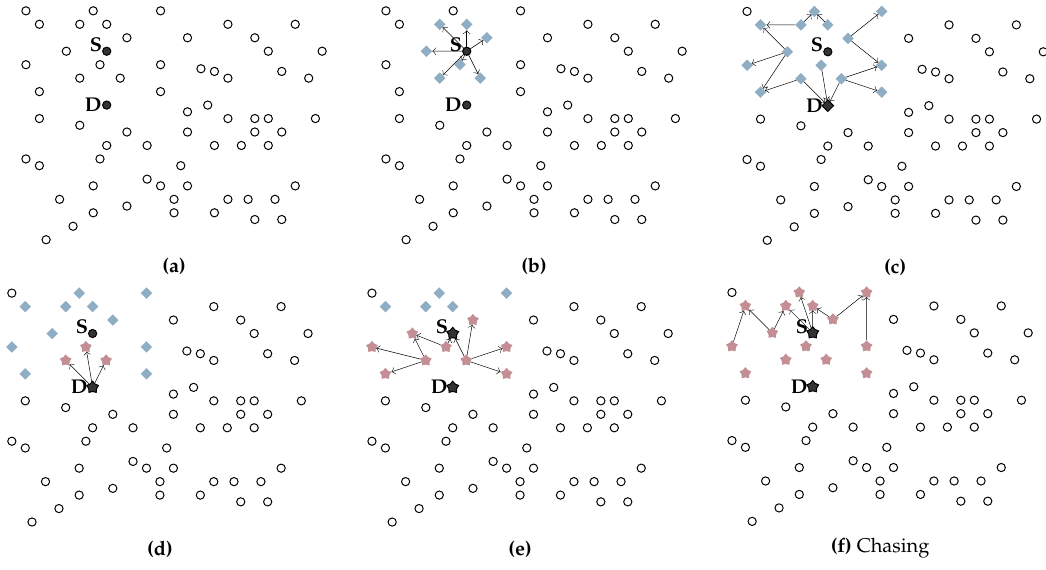
Figure 2. F&C operation. ( a – c ) Flooding stage; ( d – f ) Chasing